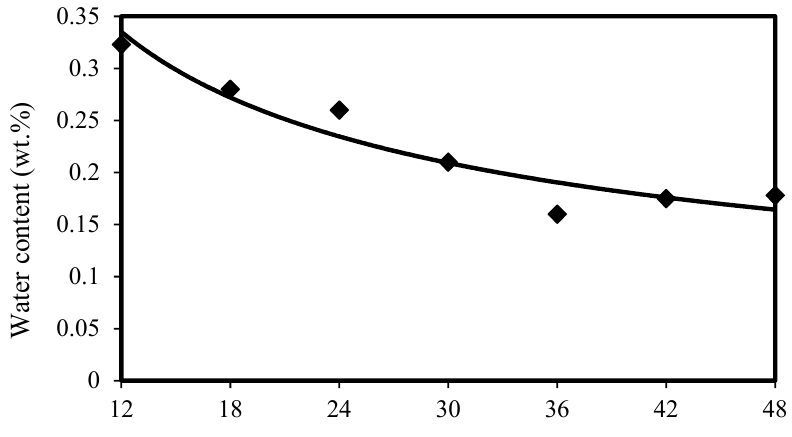
Figure 3. Water content of the biodiesel produced with various molar ratios of methanol to high-acid oil by supercritical-methanol